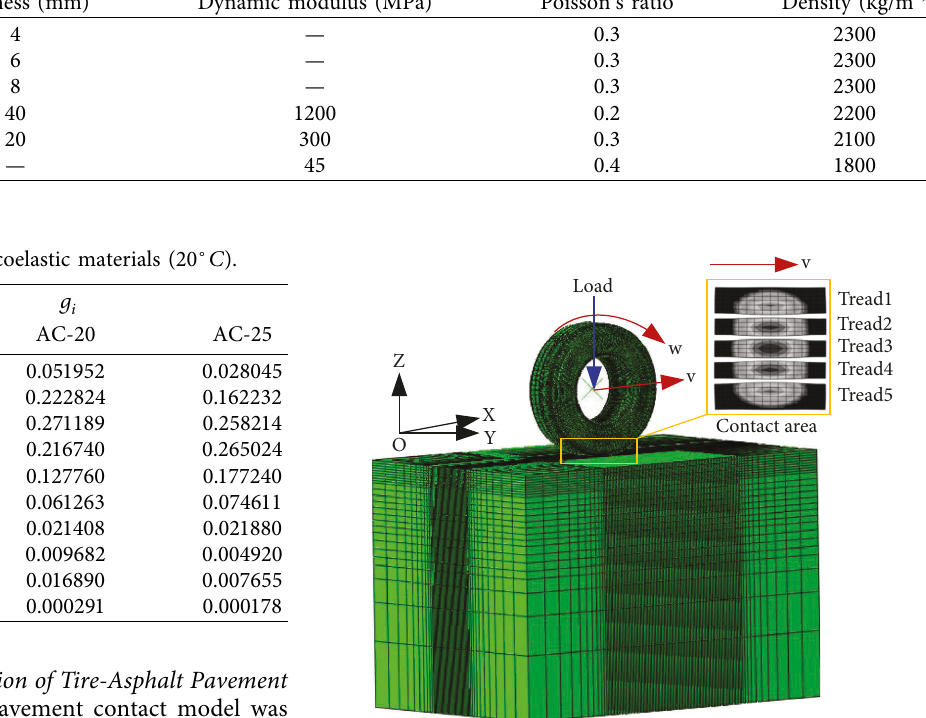
Figure 3: Tire-asphalt pavement contact model.